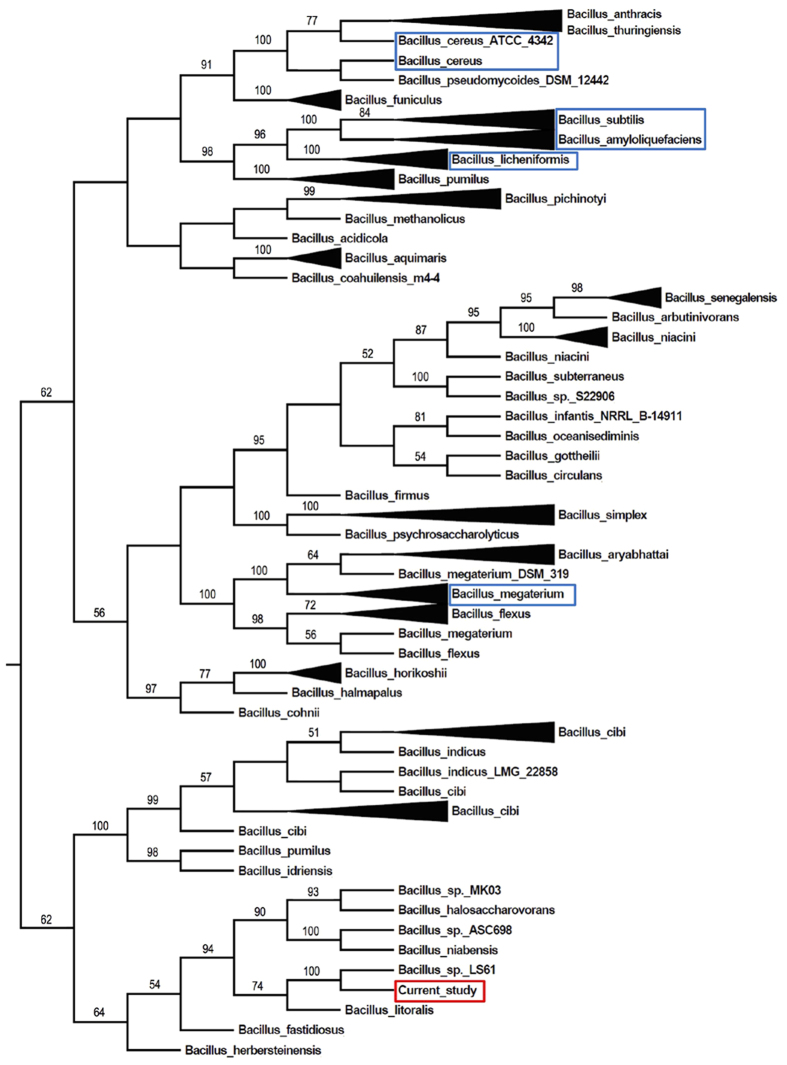
Phylogenetic tree of 16 S rRNA sequences from B. weihaiensis Alg07 and other known Bacillus species.The trees containing the same species were collapsed and indicated with triangles. Several well-studied Bacillus species are highlighted in blue frame.